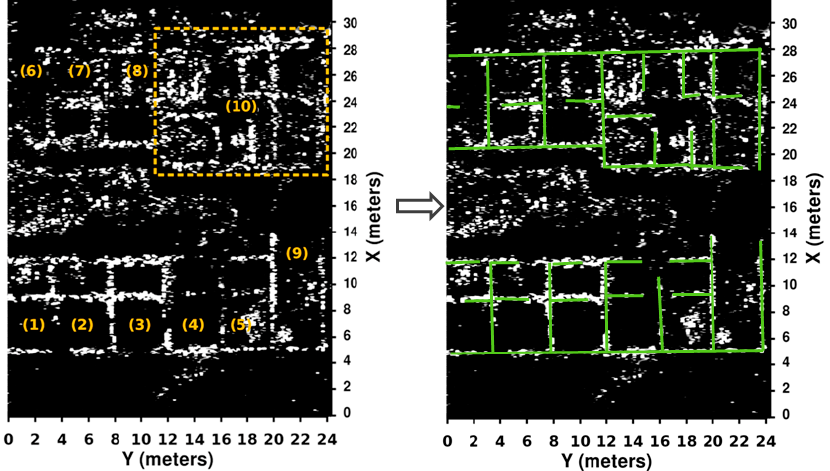
Figure 8. Results of grid 2 in the Northern sector of the camp: 3D overlaid image showing the configuration and interpretation of the contubernia identified (1–8), as well as the guard quarter (9) and the centurion’s suite (10).